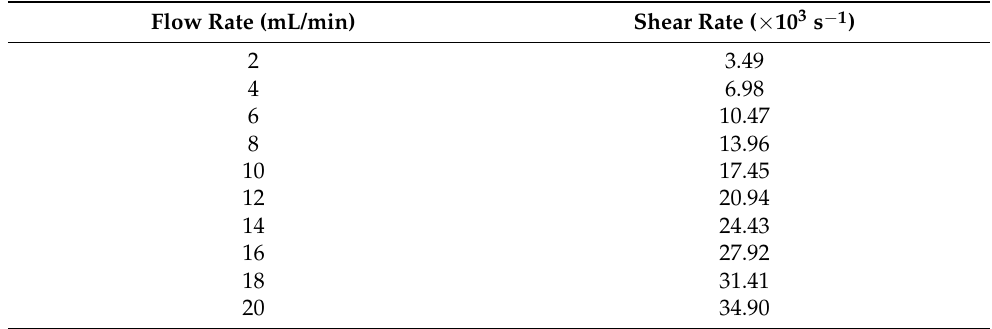
Table 1. Shear rate at different flow rate in the capillary.